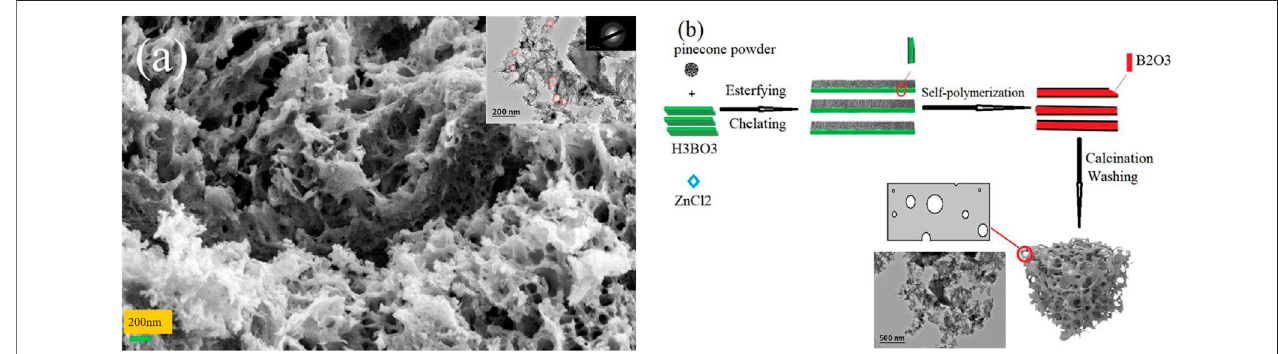
FIGURE 1 | (A) SEM and (Inset) TEM images of BZPC, (B) Schematic illustration for the formation mechanism of a thin BZPC